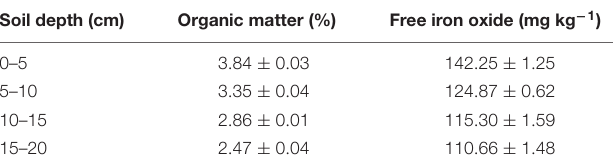
TABLE 2 | Basic properties of soils at different